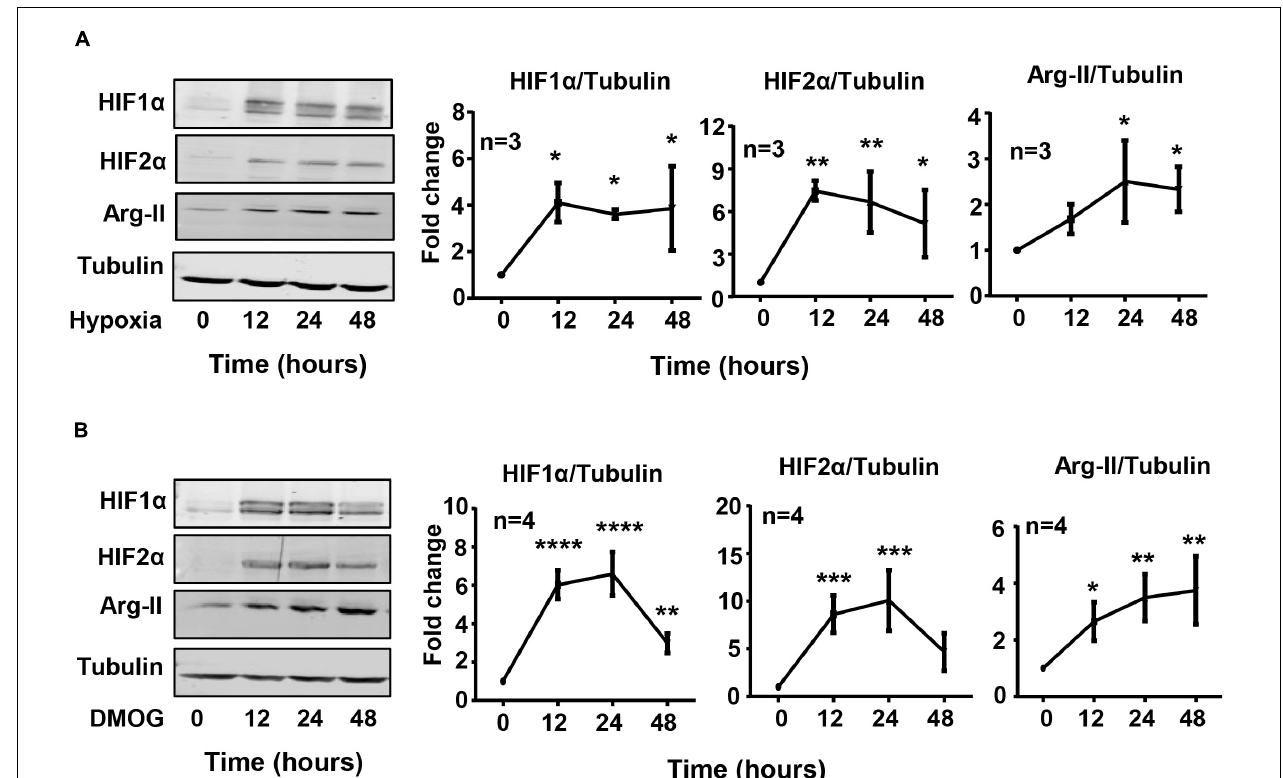
FIGURE 1 | Hypoxia and DMOG up-regulate Arg-II in HK-2 cells. (A) HK-2 cells were cultured under hypoxic condition (1% O 2 ) for indicated time. Immunoblotting reveals that hypoxia increases the protein level of HIF1 α , HIF2 α , and Arg-II in HK-2 cells. (B) Effects of DMOG (1 mmol/L) on HIF1 α , HIF2 α , and Arg-II. The graphs on the right show the quantification of the signals on immunoblots. Data are presented as mean ± SD. * P < 0.05, ** P < 0.01, *** P < 0.001, **** P < 0.0001 vs. control (time 0, normoxia). ANOVA with Bonferroni post hoc test was performed.